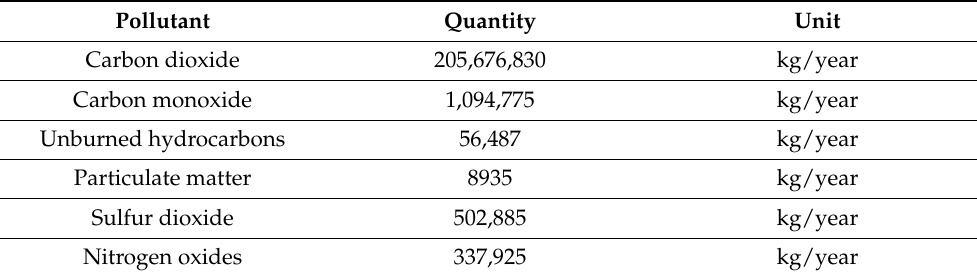
Table 3. The quantity of different emissions from the existing